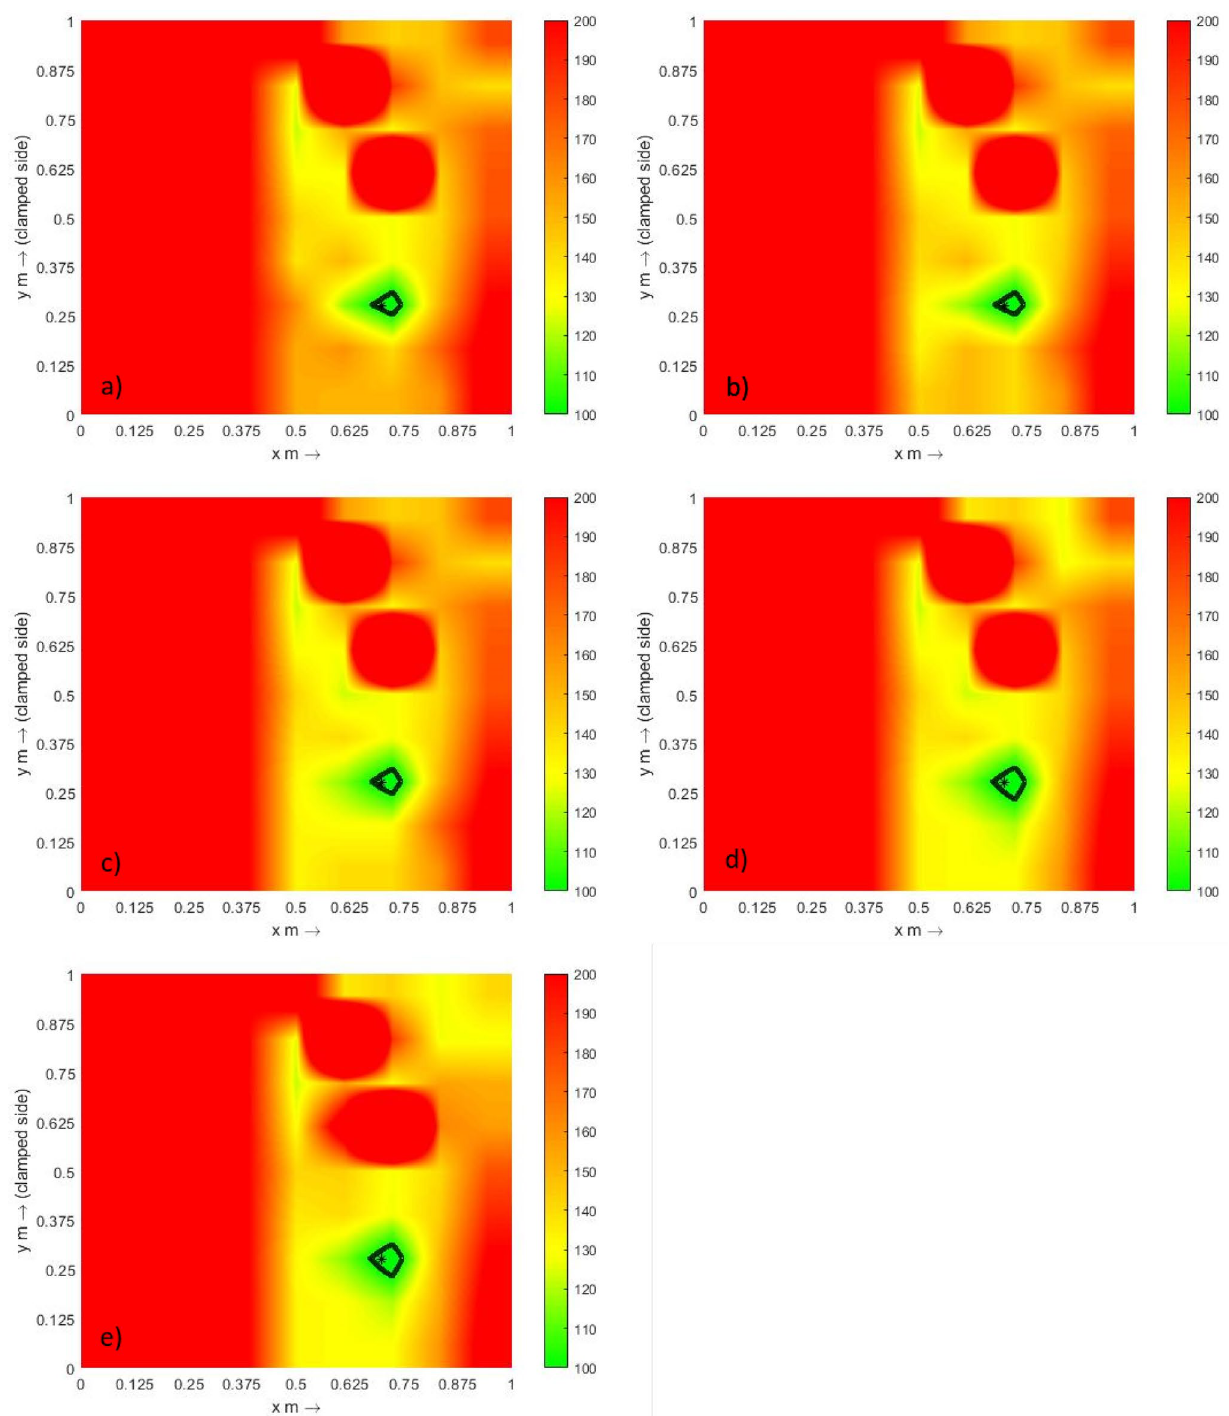
Fig. 14 Estimated region of the position of load applied for test point C using a finer grid with a deflection of a 5 mm, b 10 mm, c 15 mm, d 20 mm and e 25 mm. Asterisk marks the actual position of applied